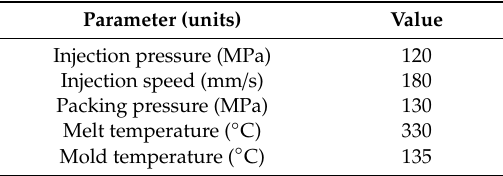
Table 2. V/P switching time optimized injection molding parameter settings. Table 2. V / P switching time optimized injection molding parameter